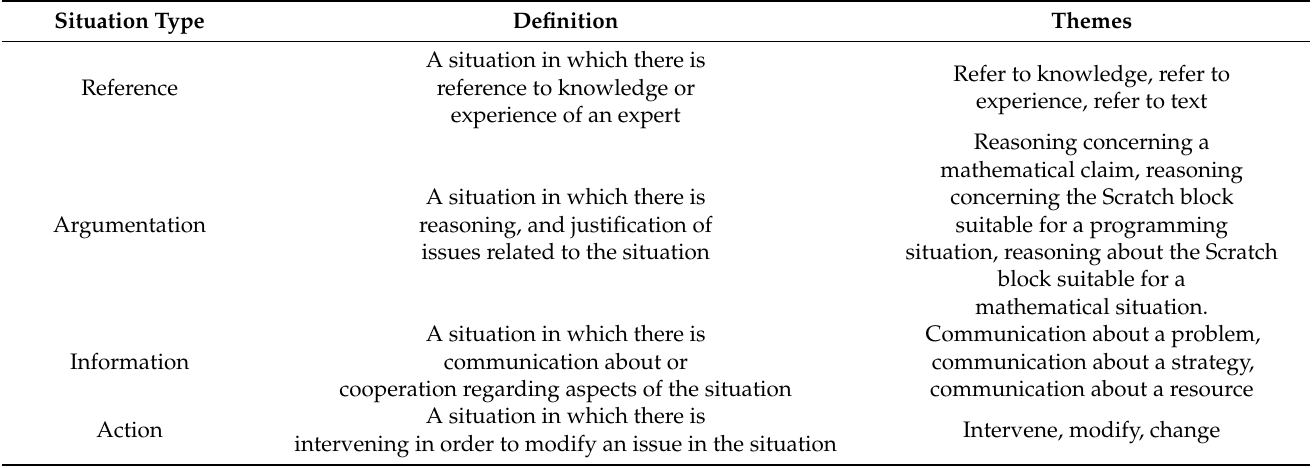
Table 1. Categories of didactical situation types, their definition, and their themes.